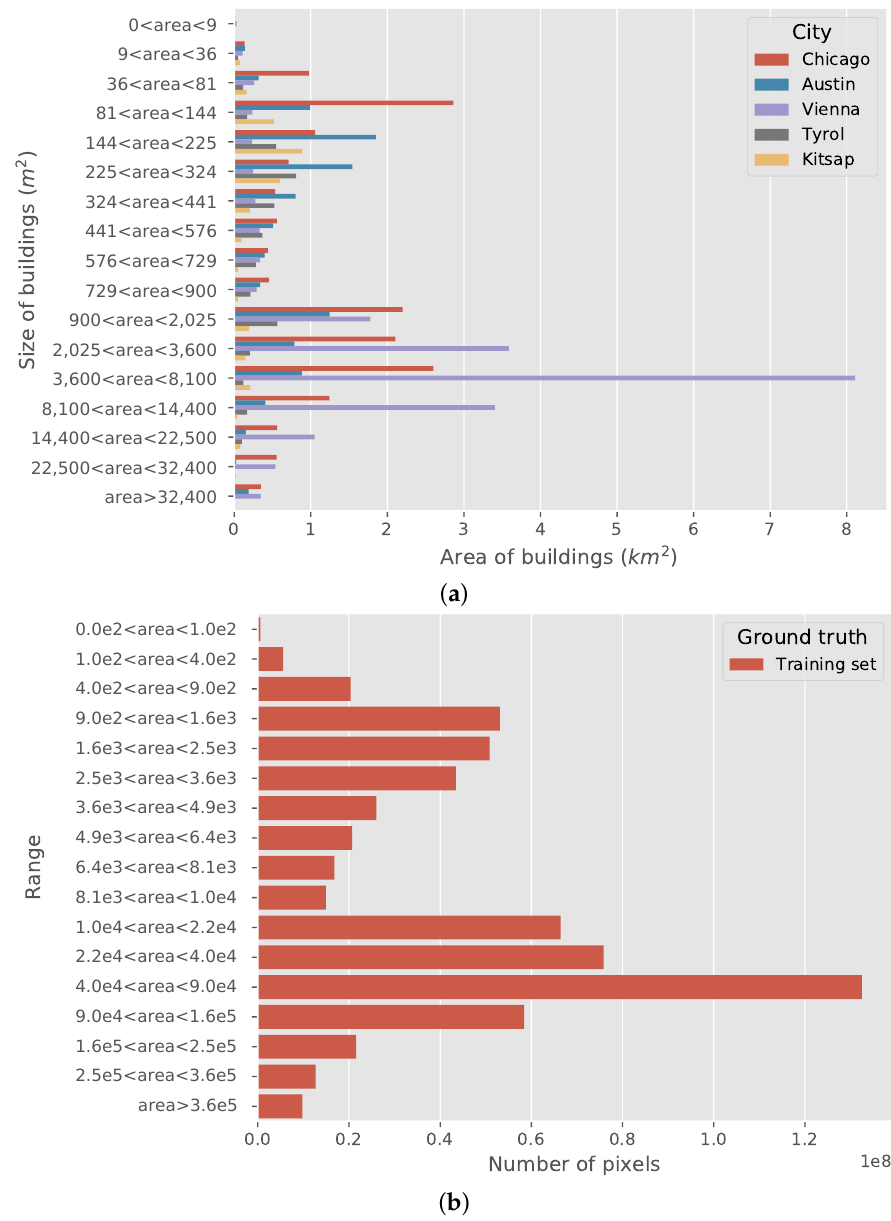
Figure 2. Building areas of five cities from the Inria building dataset: ( a ) plots the building size with respect to each city. The units of the building size in this figure are m 2 and km 2 . The distributions of the building size are quite diverse in these cities. It should be noted that the intervals of building size are not divided evenly; ( b ) plots the building size of the entire dataset using the number of pixels as the unit. The values are calculated based on the ground truth of the dataset. Most of the buildings are smaller than 250,000 pixels (500 500). Therefore, the image tiles are divided into patches with a × size of 512 512 when ×